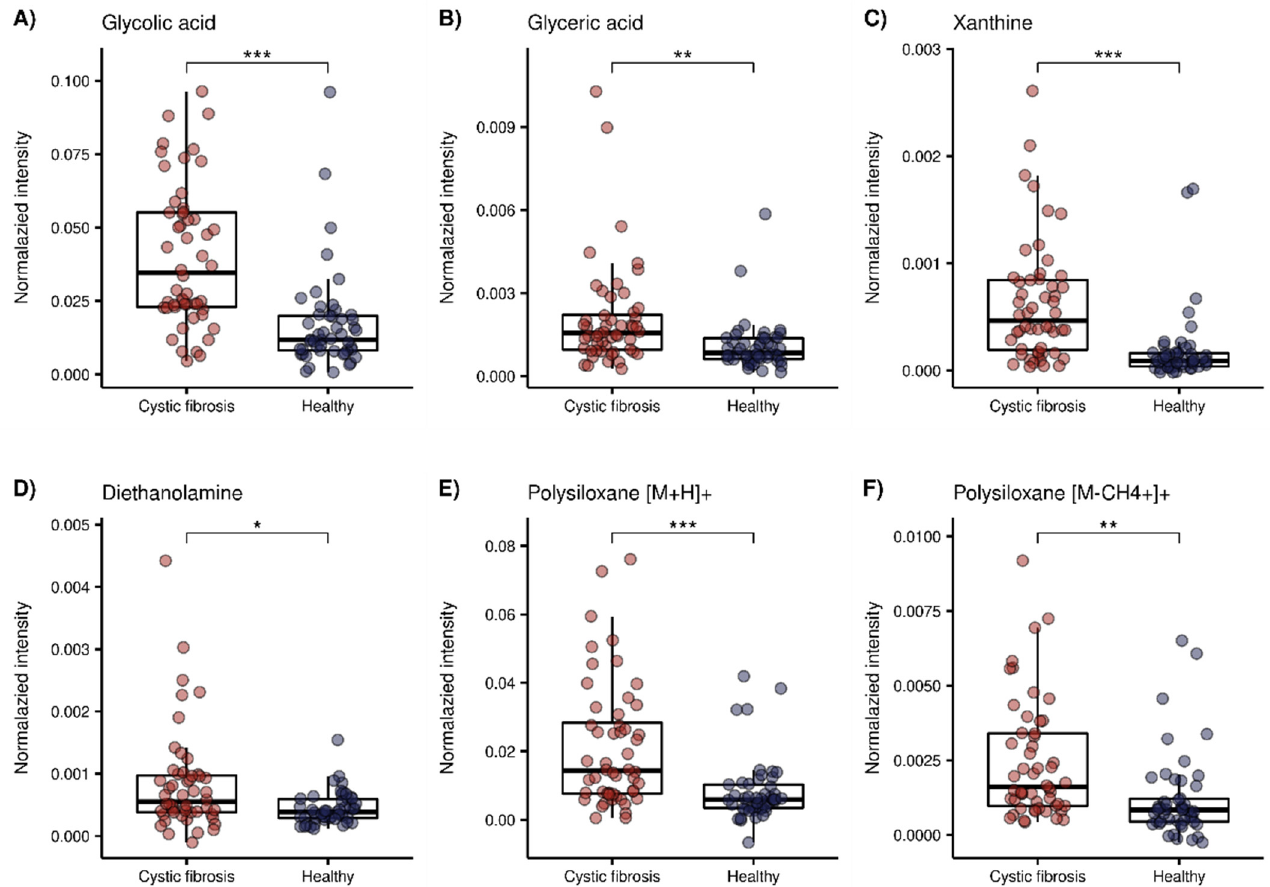
Figure 4. Box plots of a selection of compounds elevated in the CF group. Red = CF patients, blue = healthy controls (*: p < 0.05, **: p < 0.01, ***: p < 0.001 with FDR adjusted p -values taken from our previous work [30]). ( A ) Glycolic acid ( m/z − 75.0085), ( B ) glyceric acid ( m/z − 105.018), ( C ) xanthine ( m/z − 151.0247), ( D ) Diethanolamine ( m/z + 106.0858), ( E ) polysiloxane [M + H]+ ( m/z + 445.12), ( F ) polysiloxane [M-CH4 + H]+ ( m/z + 429.088).